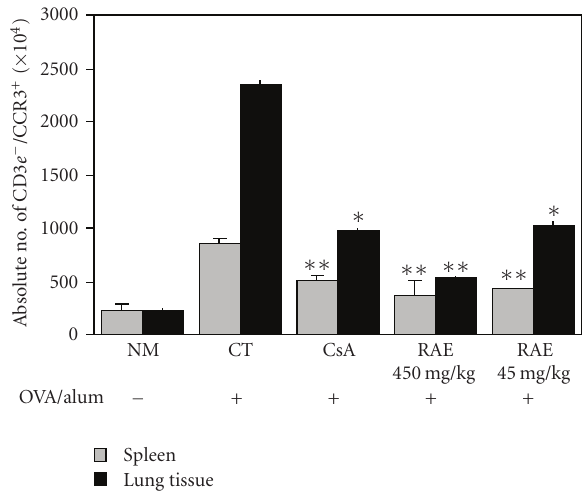
Figure 5: E ff ect of RAE on CD3e − /CCR3 + population in lung tissues of OVA-induced asthma murine (NM: normal C57BL/6 mice; CT: OVA-induced asthma mice (control); CsA: OVA- induced asthma mice treated with cyclosporine A (10mg/kg); RAE 450 mg/kg: OVA-induced asthma mice treated with RAE (450mg/kg); RAE 45 mg/kg: OVA-induced asthma mice treated with RAE